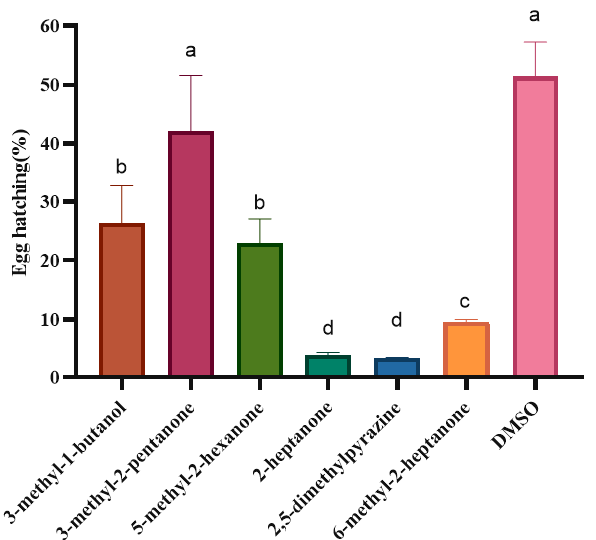
Figure 3. E ff ects of direct contact of six VOCs on the egg hatching of M. hapla after 7 days . Di ff erent Figure 3. Effects of direct contact of six VOCs on the egg hatching of M. hapla after 7 days. Different lowercase le tt ers indicate signi fi cant di ff erences among treatments ( p < 0.05); bars indicate the stand- lowercase letters indicate significant differences among treatments ( p < 0.05); bars indicate the ard error of the means ( n = 3). standard error of the means ( n =